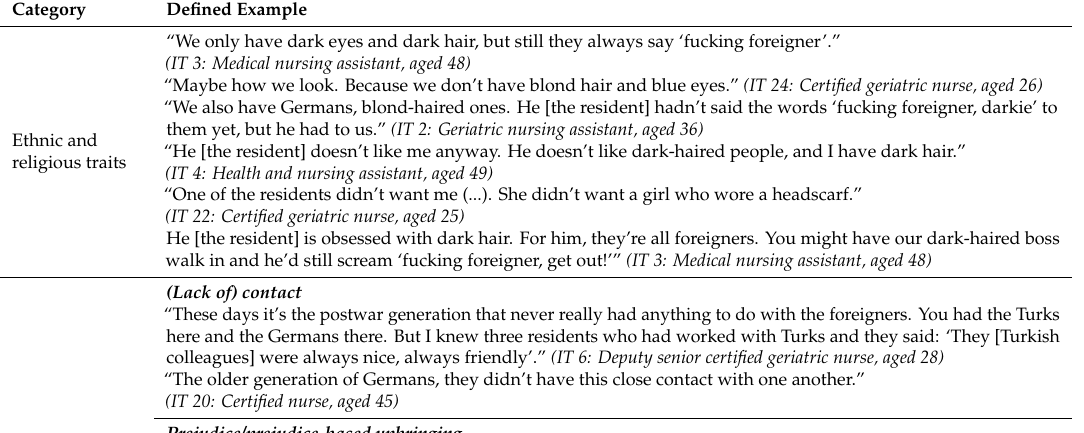
Table 3. Reasons for